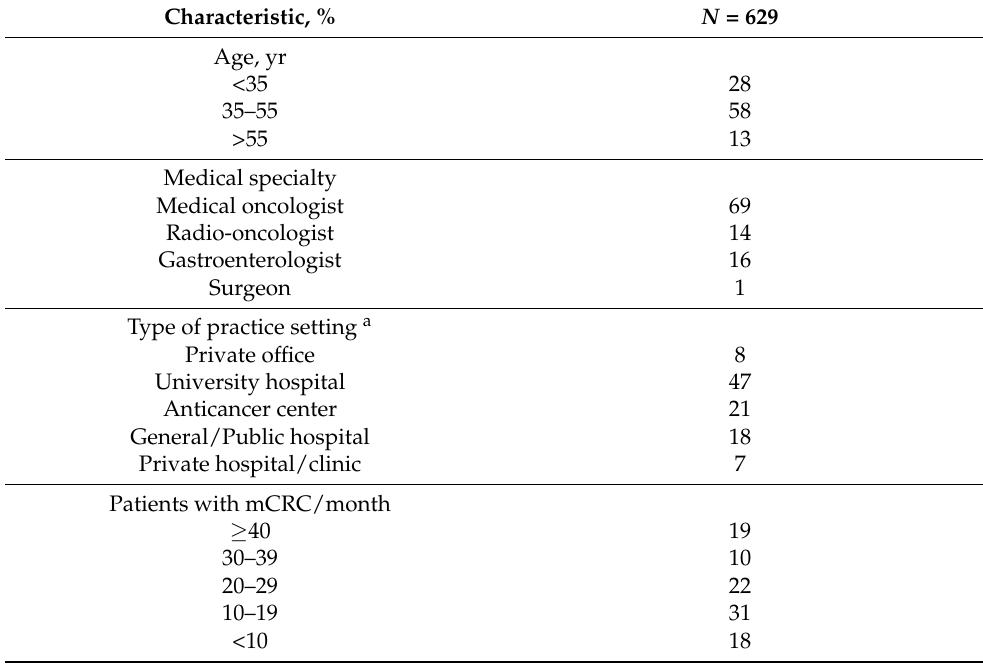
Table 1. Demographics of participants (final-analysis